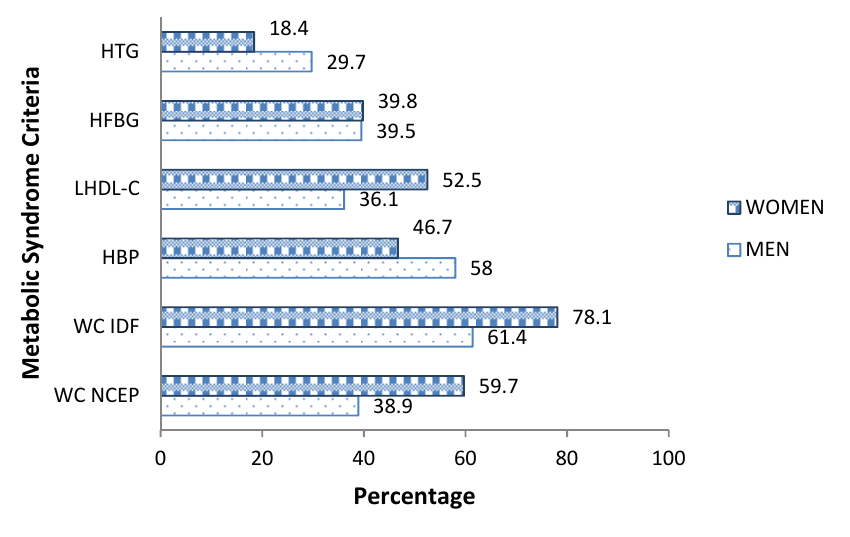
Figure 2. Overall prevalence of the metabolic syndrome components by gender in Kuwaiti